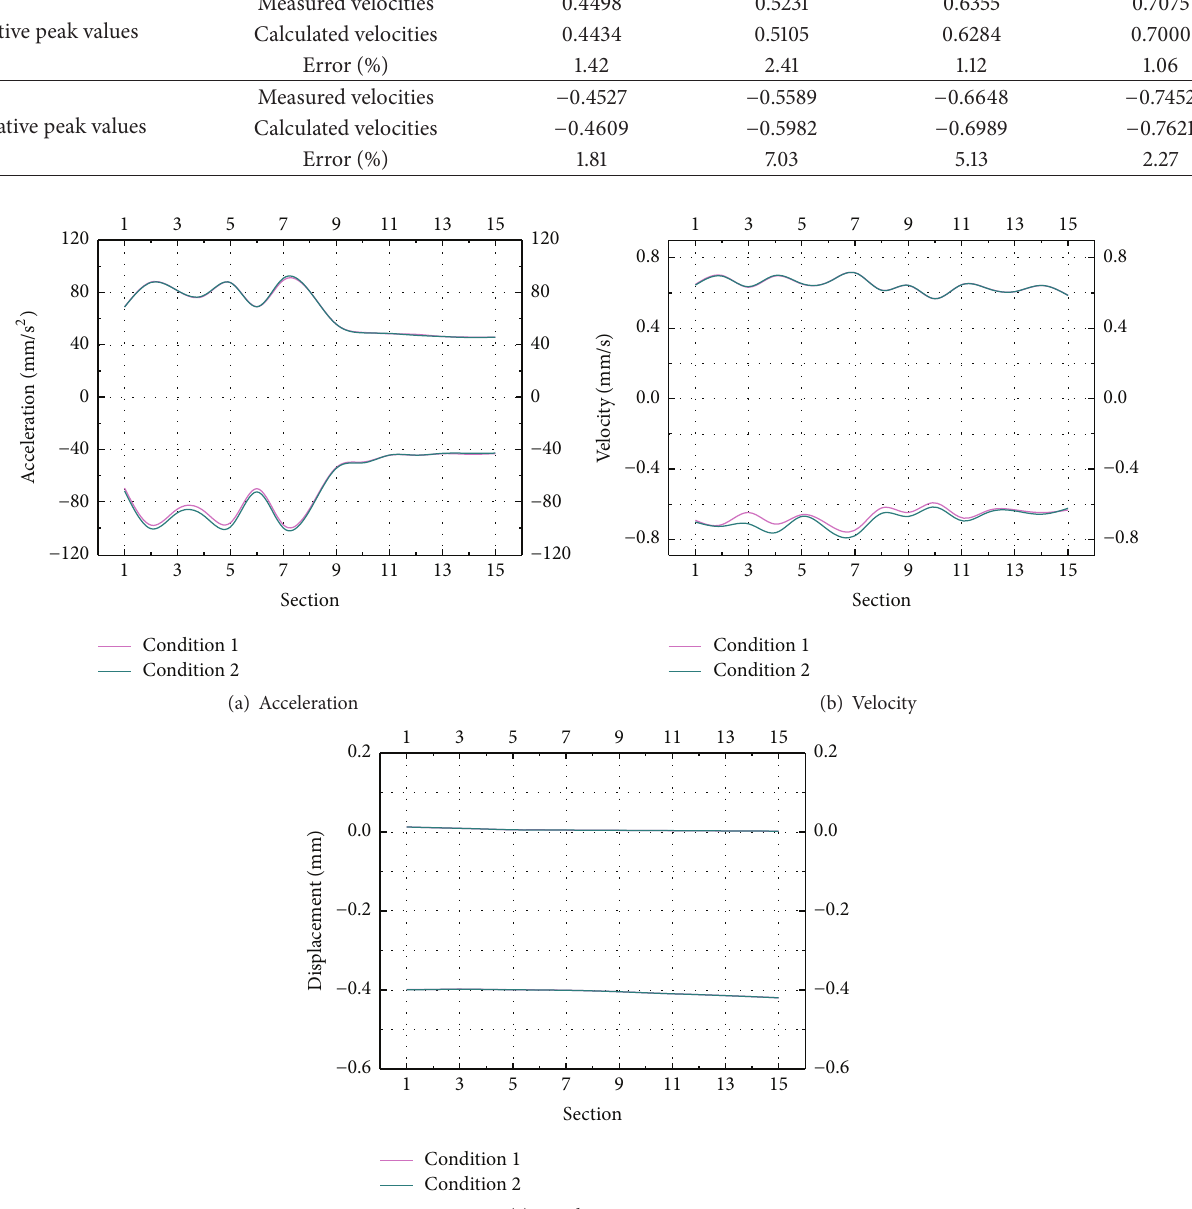
Table 6: Verification with measured and calculated velocities at different studied positions (unit: mm/s) [33]. Studied positions A B Positive peak values